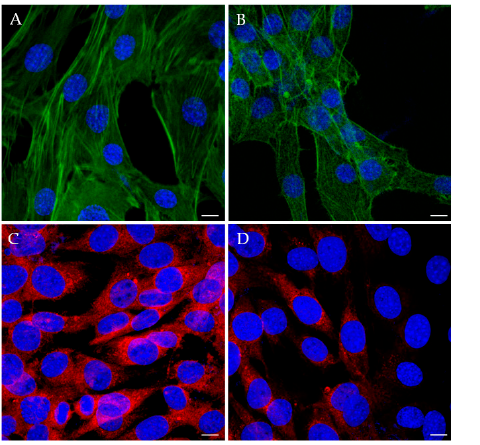
Figure 4. Immunolabeling of Actin and MitoTracker. C2C12 cells at 24 h post-treatment, cells incubated with phalloidin (green) and MitoTracker (red) conjugated dyes. DAPI (blue) was used for nuclear counterstaining. ( A , C ) Vehicle (DMSO) ( B , D ) CCG-1423 treated cells, at 10 µ M dosage. 63 × oil objective is used; scale bars indicate 10 µ m. ( E ) MitoTracker stained cells are randomly selected microscopic fields in four individual repetitions where the fluorescence intensity was quantified using ImageJ. **** p < 0.0001 ( n = 4).